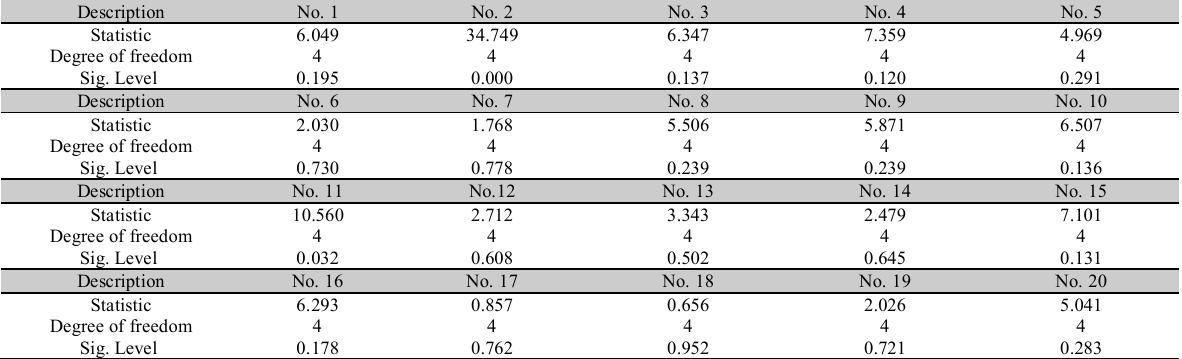
The Summary Results of Education Level ANOVA Description No. 1 No. 2 No. 3 No. 4 Degree of freedom Sig.